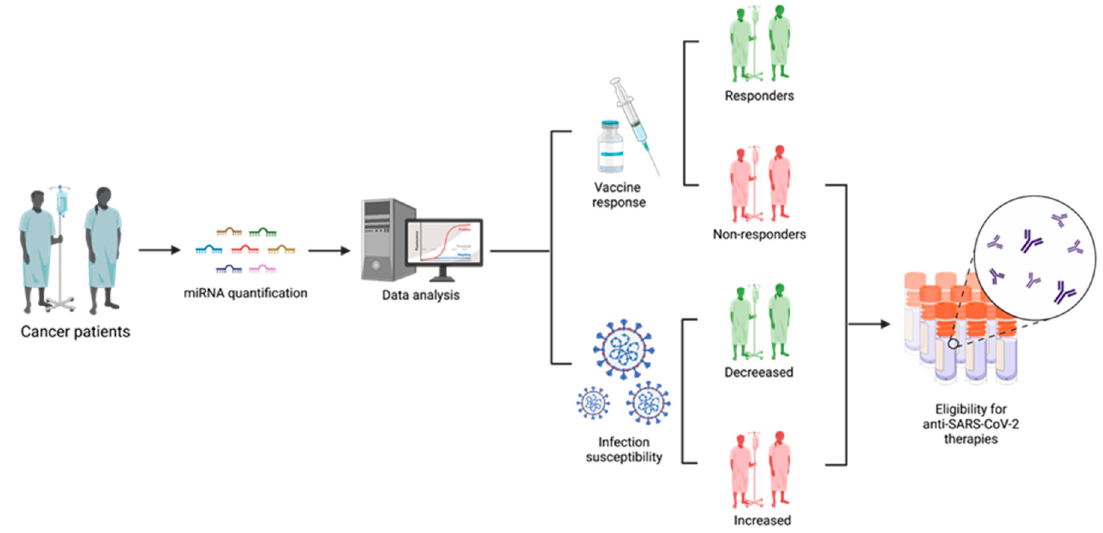
Figure 3. Schematic representation of the applicability of using miRNA profiles to stratify cancer patients according to their prognostic in terms of SARS-CoV-2 infection risk and vaccination responsiveness. This figure was created at BioRender.com. (accessed on 12 July 2022).